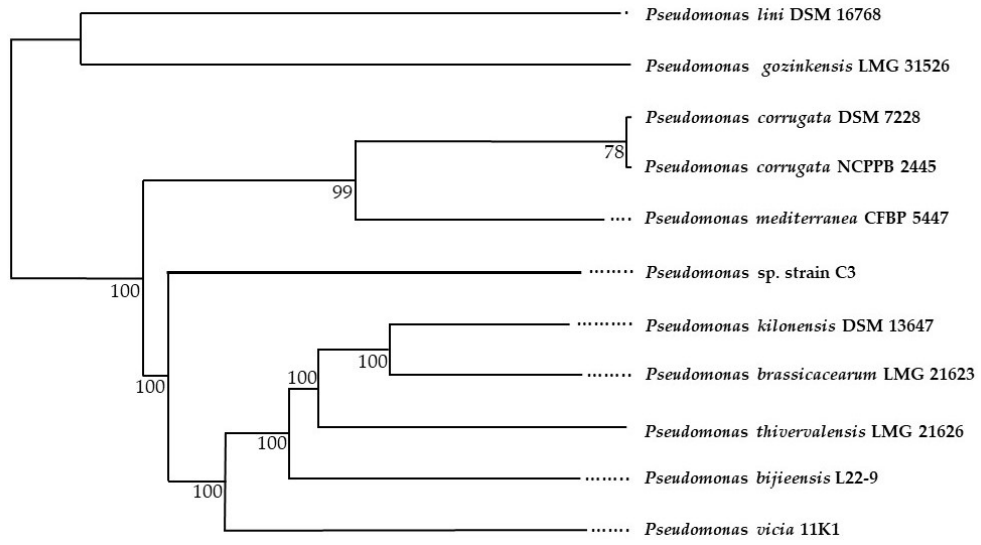
Figure 2. Phylogenetic analysis with taxonomic inference based on the genomic sequence of Pseu- domonas sp. strain C3 for microbial species delimitation by dDDH (digital DNA-DNA hybridization). The dots in the figure represent evolutionary events for each bacterium.